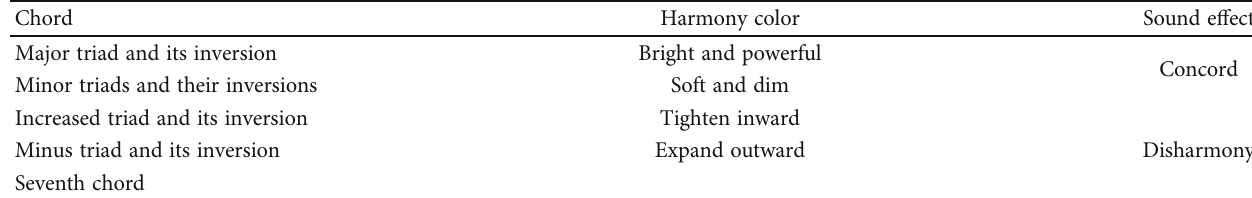
Table 2: Analysis of harmony color and sound e ff ect of chord